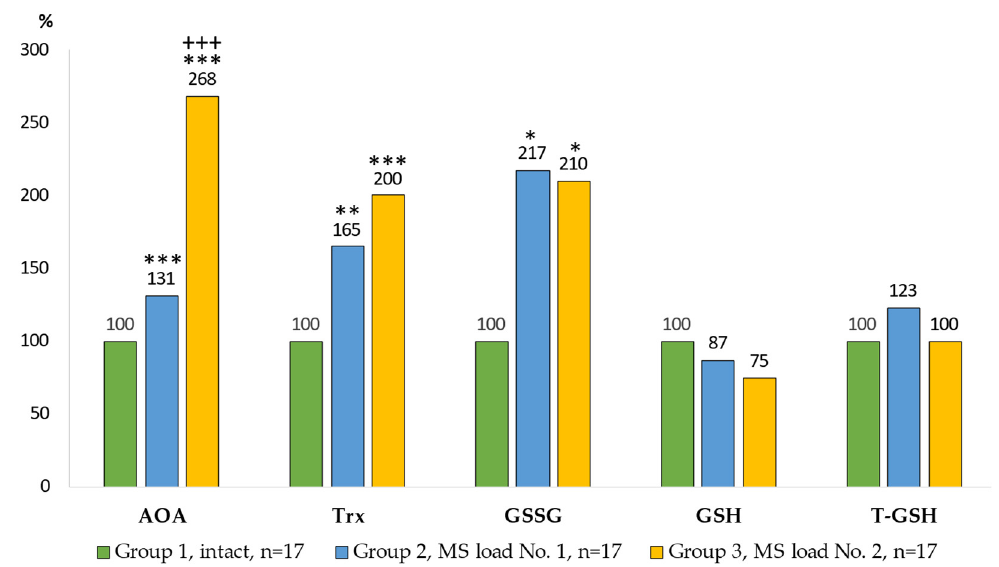
Figure 3. Indicators of the antioxidant system in the AM culture. Notes: statistical significance relative to Group 1: *— p < 0.05; **— p < 0.01; ***— p < 0.001; relative to Group 2: +++— p < 0.001.